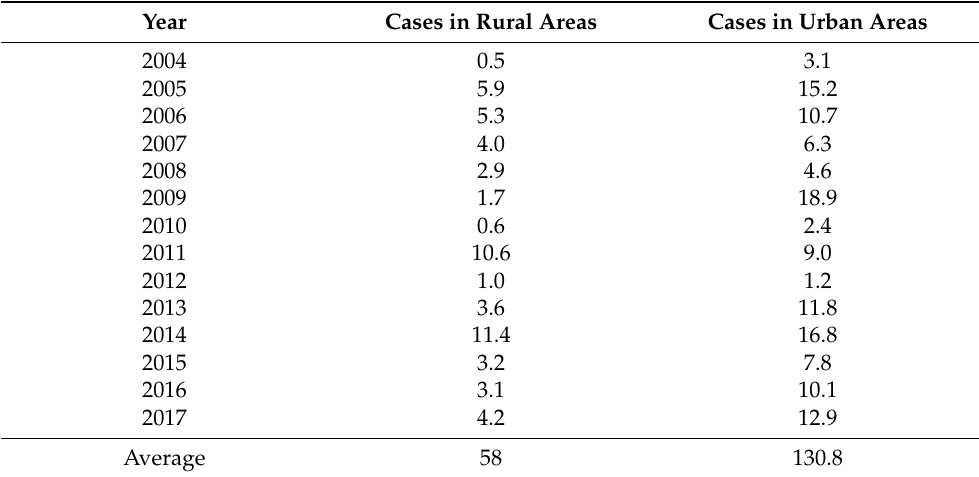
Table A1. Analys of confirmed per-capita Dengue cases (cases per 1000 inhabitants) in rural and urban areas within the metropolitan region of